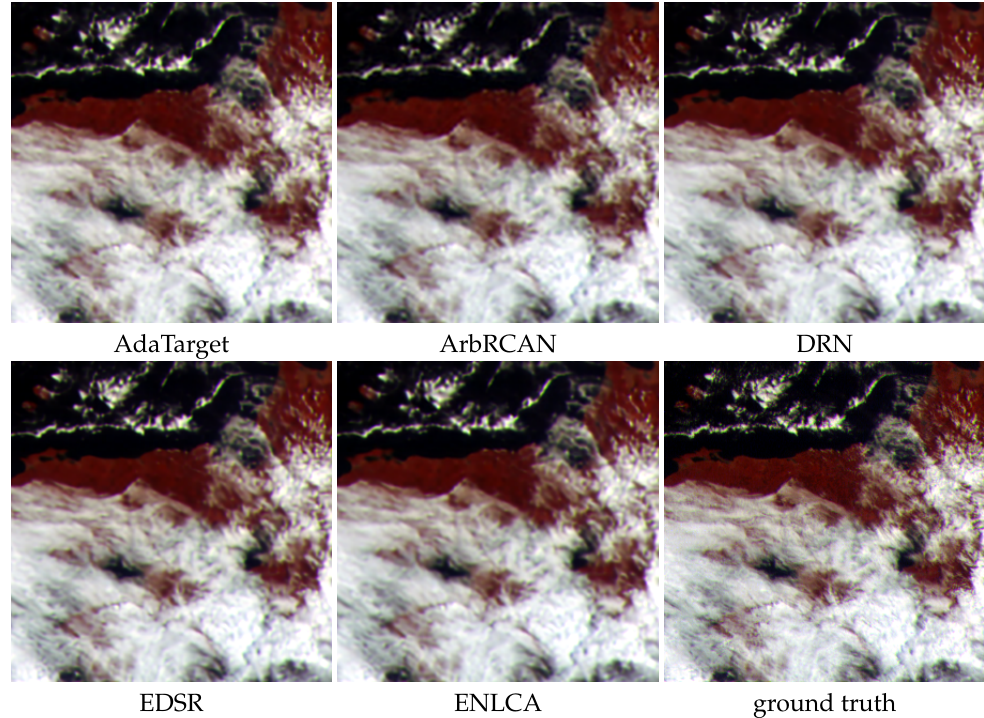
Figure 13. Local manifestation of the super-resolution results on the FY4ASRcolor dataset: Patch